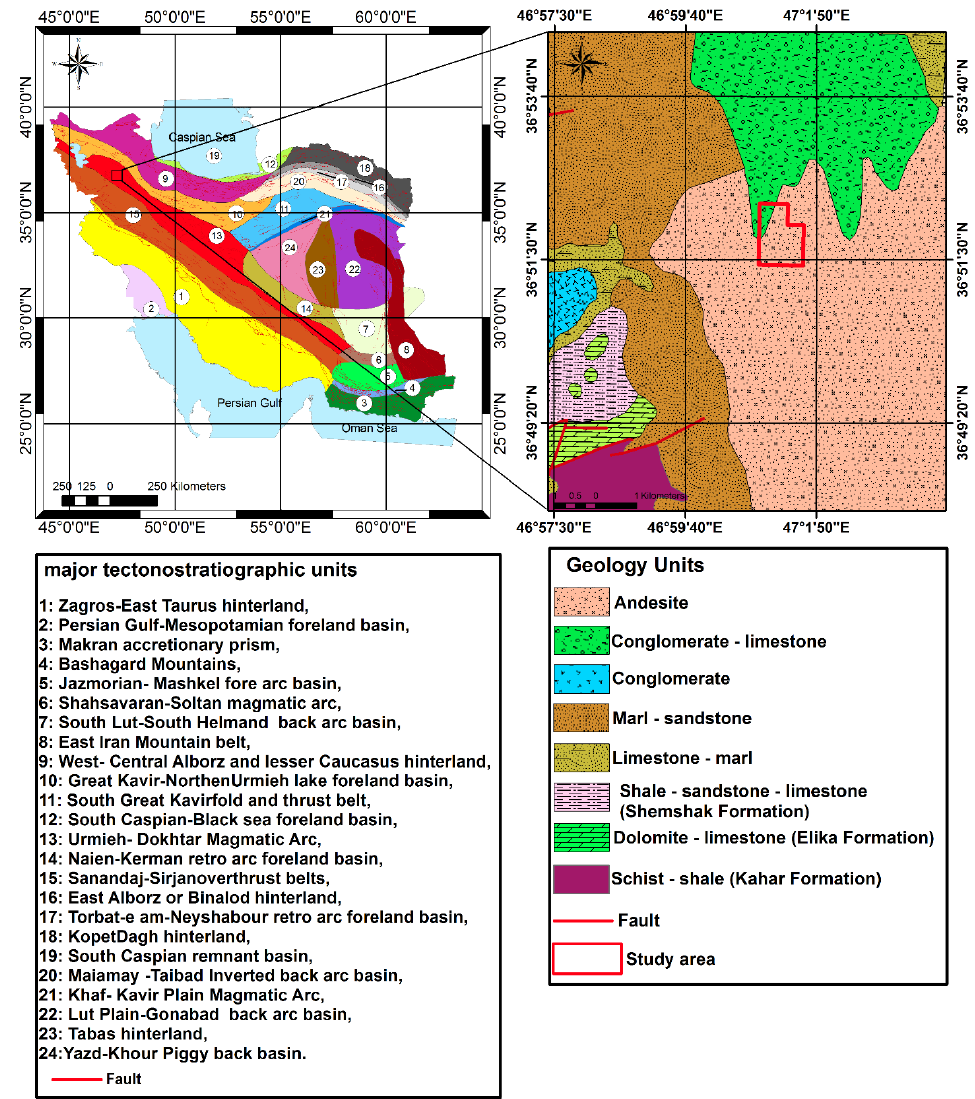
Figure 1. Physiographic–tectonic zoning map of Iran’s sedimentary basins (Arian, 2013) and location of the study area.